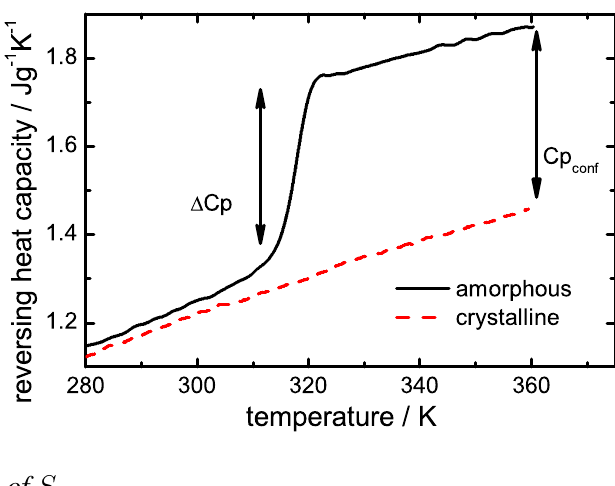
Figure 2. Heat capacity difference ( ∆ Cp) and configurational heat capacity (Cp ) of conf